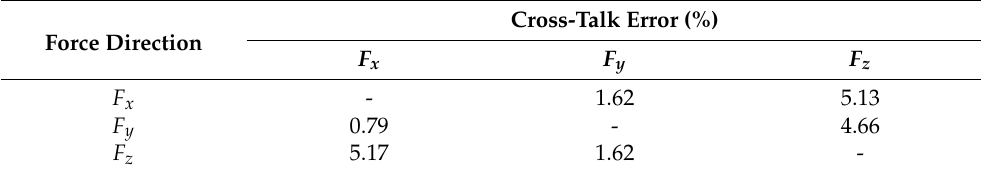
Table 1. Cross-talk error of the dynamometer based on static calibration